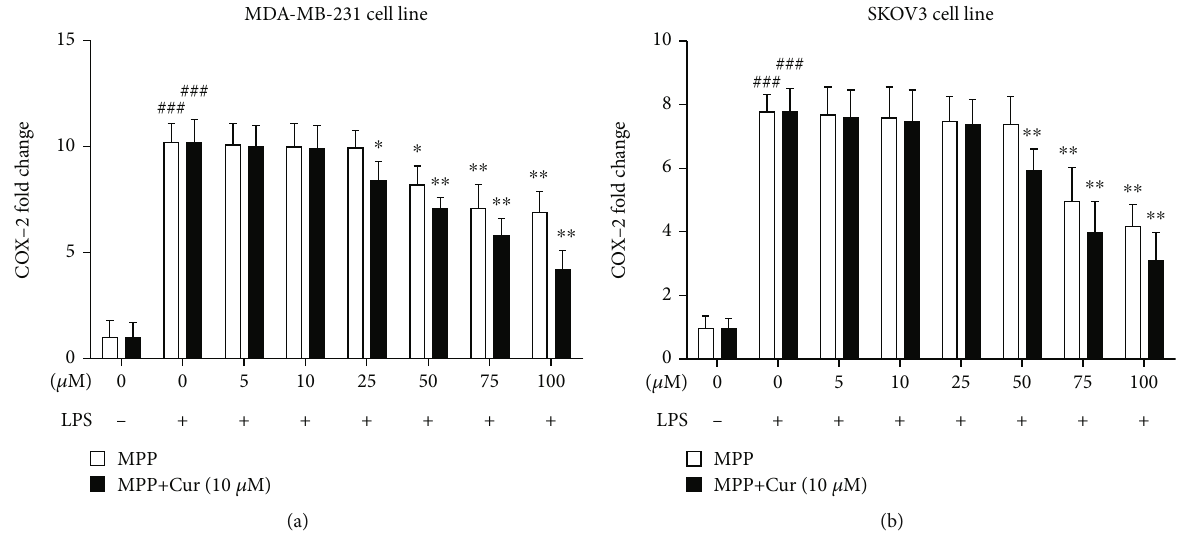
Figure 5: Gene expression of COX2 in LPS-stimulated (a) MDA-MB-231 and (b) SKOV3 cells, in response to various concentrations of MPP, either alone or combined with 10 μ M curcumin. ### P < 0 : 001 compared with untreated unstimulated control cells; ∗ P < 0 : 05 , ∗∗ P < 0 : 01 , and ∗∗∗ P < 0 : 001 compared with LPS-stimulated untreated cells. The results are mean ± SD of at least three independent